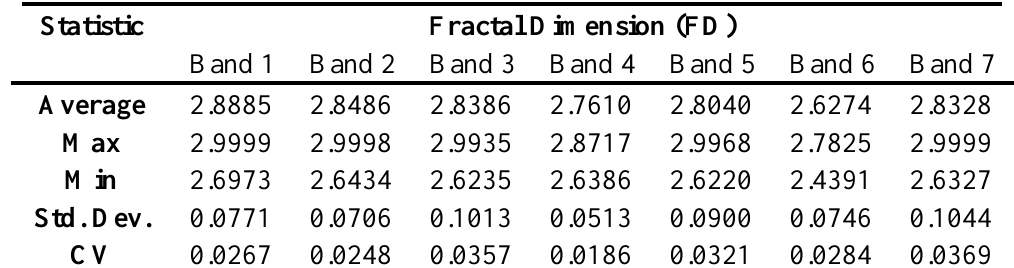
National Forest.